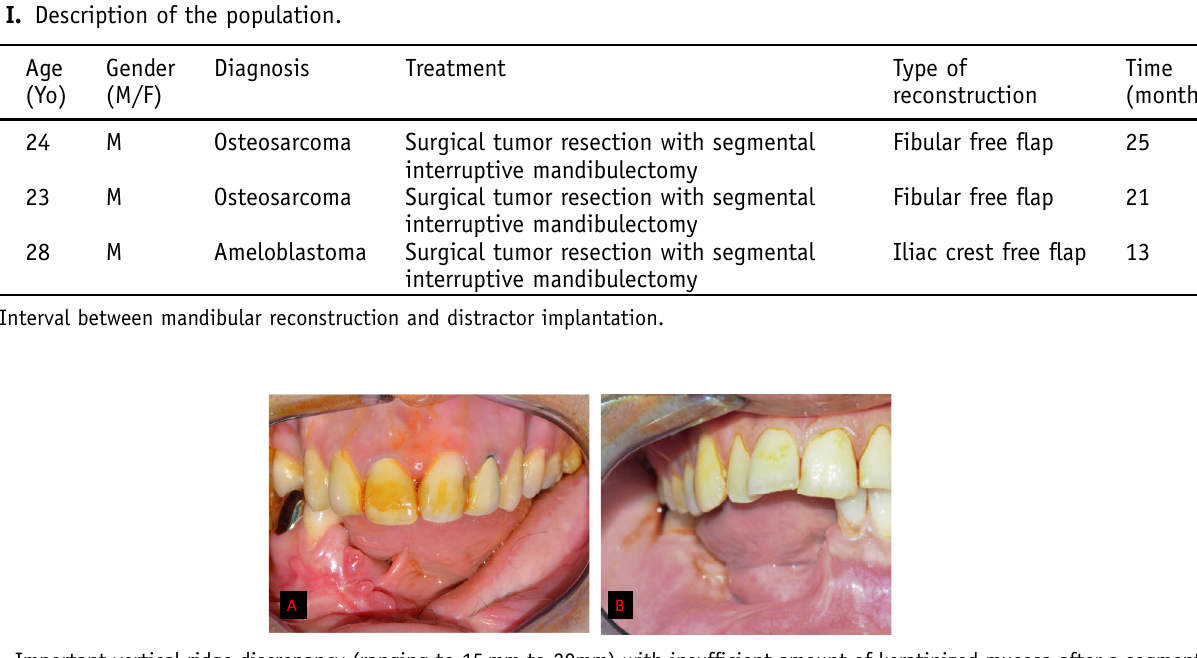
Fig. 1. Important vertical ridge discrepancy (ranging to 15mm to 20mm) with insuf fi cient amount of keratinized mucosa after a segmental